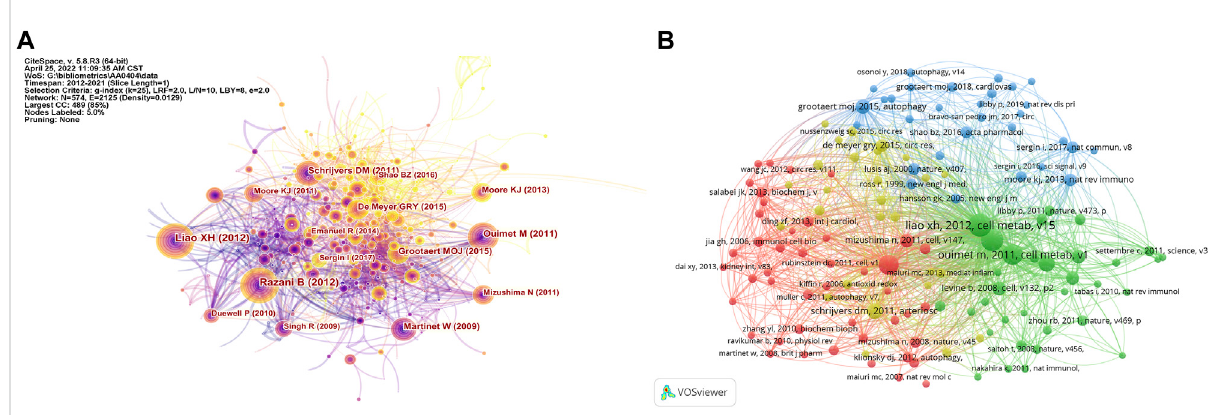
FIGURE 6 Analysisofcitedarticlesandco-citedreferences. (A) AnalysisofcitedarticlesbasedonCiteSpacevisualmap; (B) Analysisofco-citedreferences based on VOSviewer visual